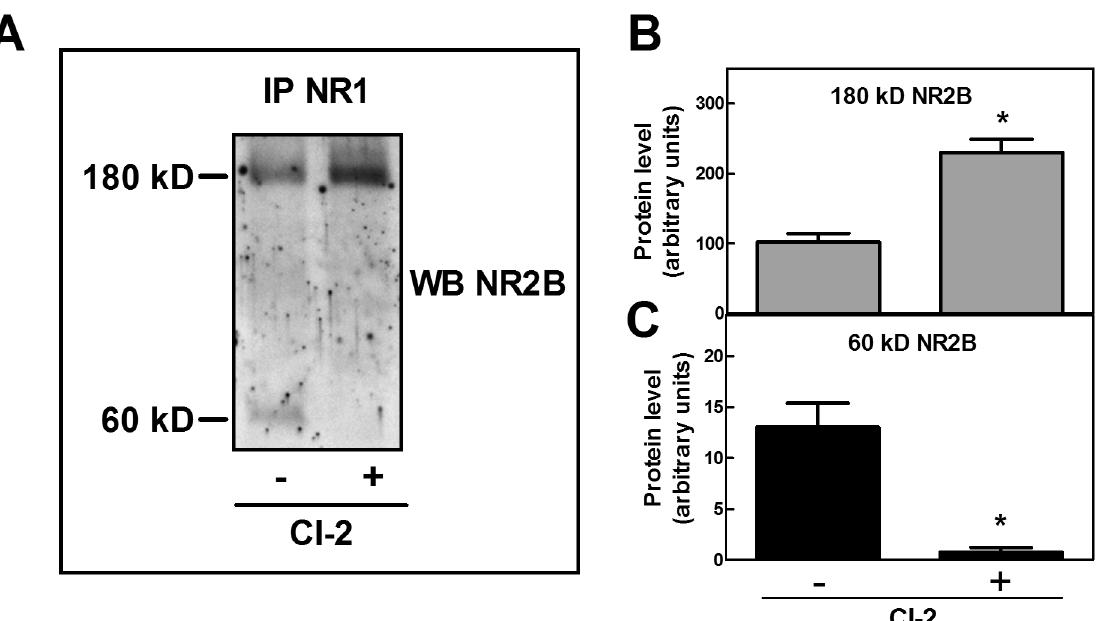
Fig 3. Effect of calpain inhibition on NR2B protein levels in SKNBE cells. (A) SKNBE cells were incubated for 24 hours in the absence or presence of 1 μ M Calpain inhibitor 2 (CI-2), and lysed to perform immunoprecipitation with 1 μ g of anti-NR1 antibody. The immunoprecipitated material (IP NR-1) was analyzed by immunoblotting for NR2B (WB NR2B). (B and C) The protein bands detected in (A) were quantified as described in Methods. Each value represents the arithmetical mean ± SEM of four different experiments. * p < 0.01 vs control (- CI-2), according to t -test.